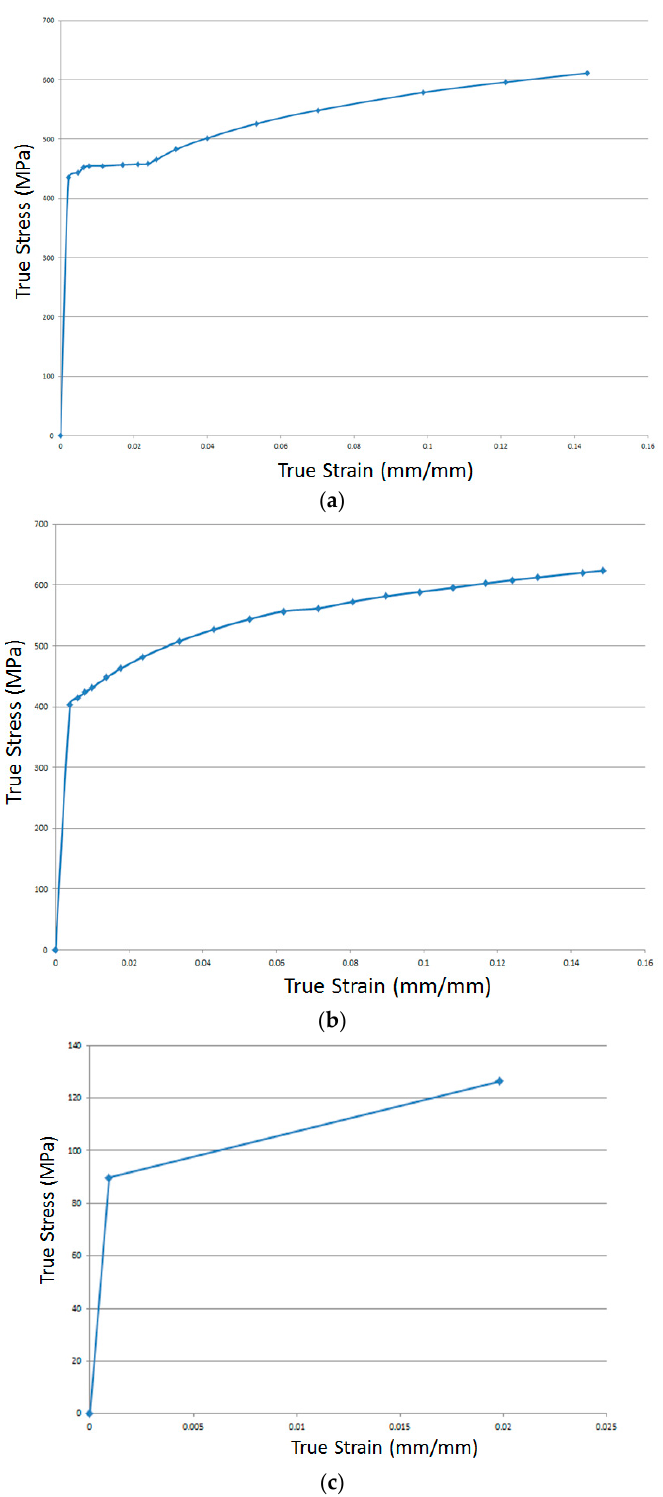
Figure 10. ( a ) True stress-strain curve of S355MC; ( b ) true stress-strain curve of 20MnB4; ( c ) true stress-strain curve of F-0000-10.